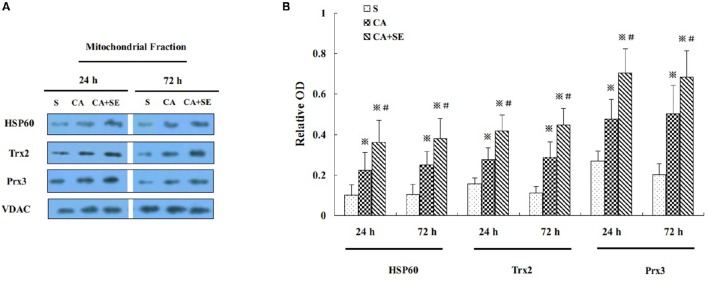
Effect of sevoflurane post-conditioning on mitochondrial antioxidnt protein expression. (A) Representative Western blots showing HSP60, Prx3, and Trx2 protein levels in rats in the presence and absence of sevoflurane; (B) Graph showing semiquantitative analysis showing the protein levels of HSP60, Prx3, and Trx2. Data are expressed as mean ± S.D. n = 6–8 rats for each group. ※P < 0.05 vs. the sham group; #P < 0.05 vs. the CA group.